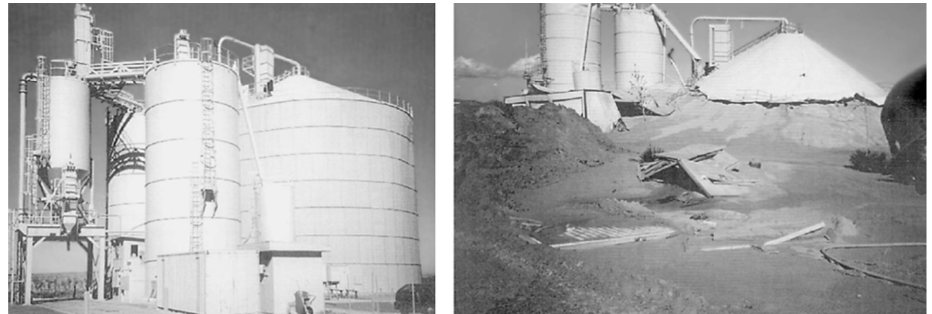
Figure 9. Steel silo of 24 m diameter split apart about two weeks after its first full capacity filling. Source: [116].